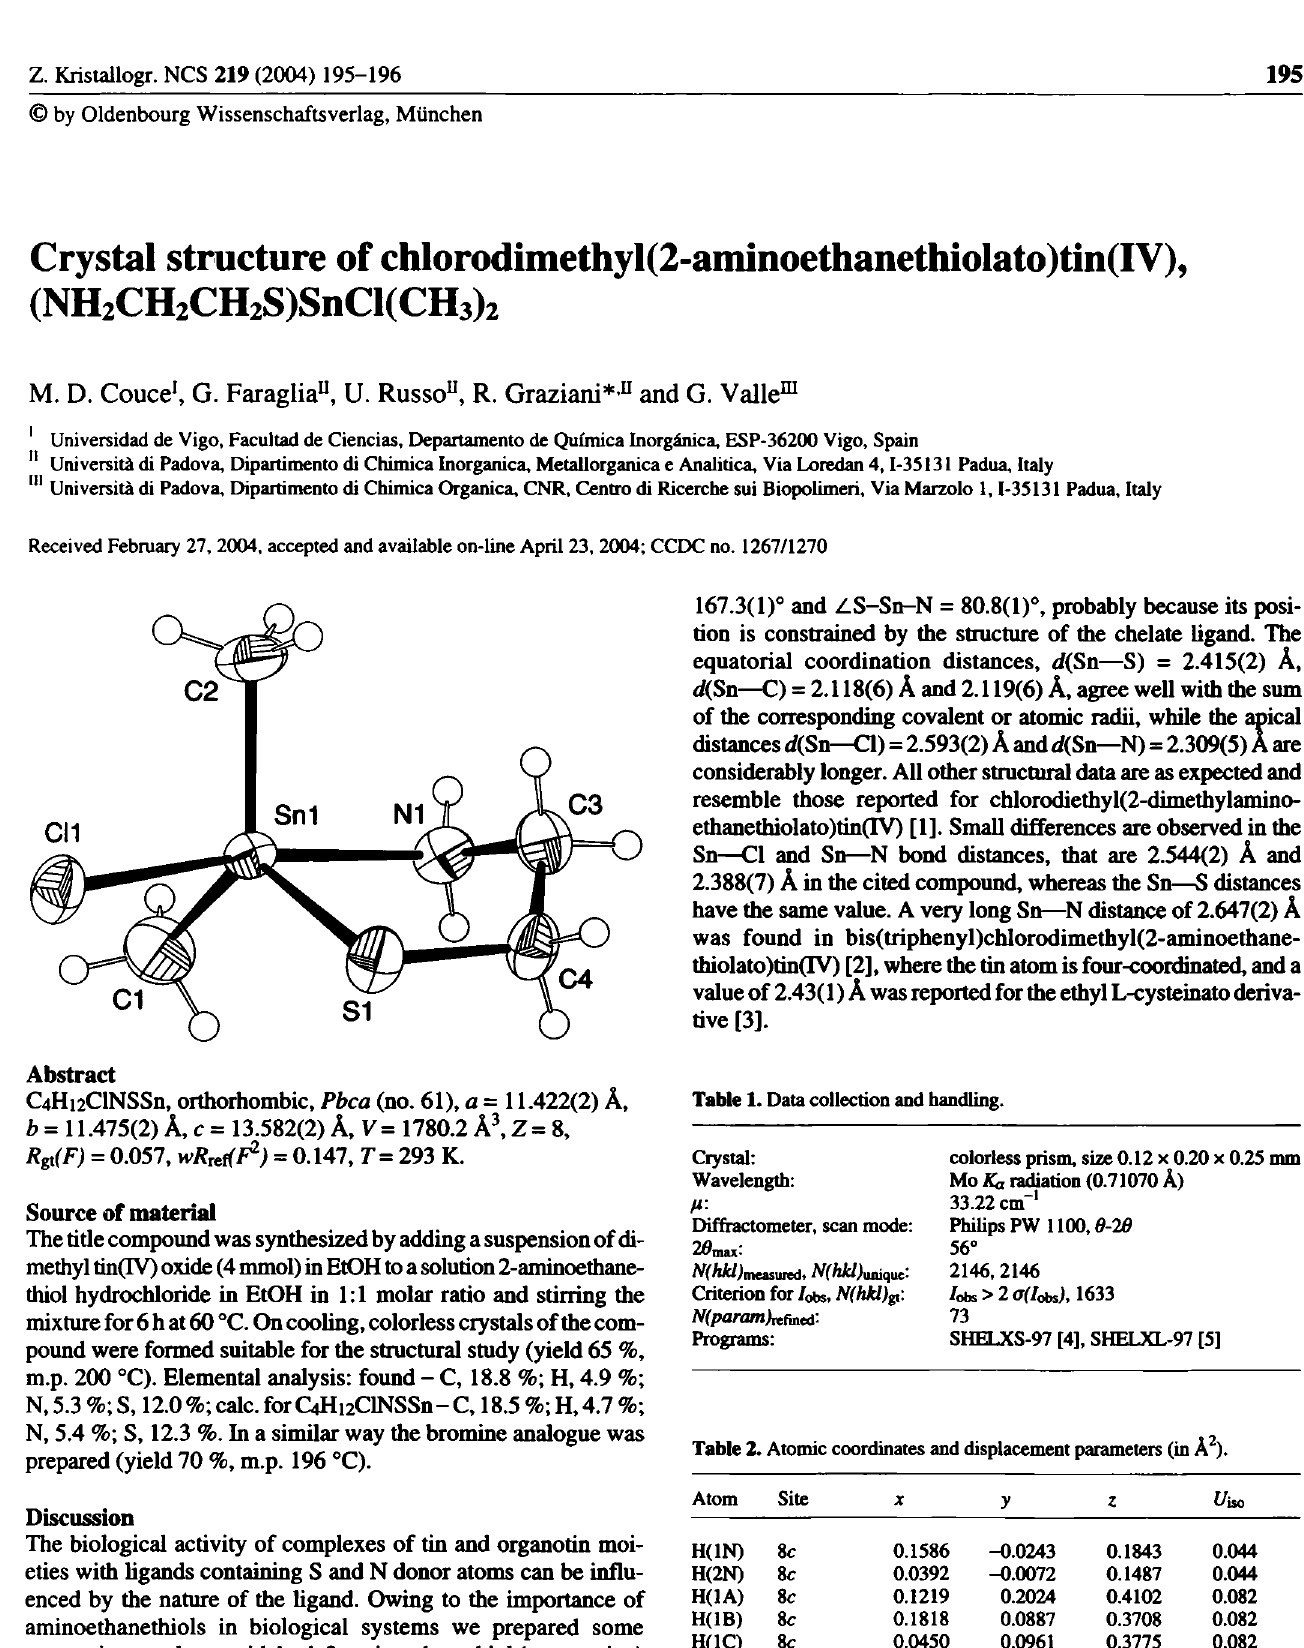
Table 2. Atomic coordinates and displacement parameters (in À 2